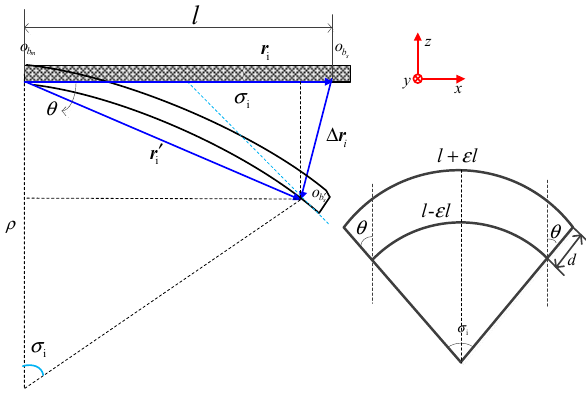
Figure 5. Schematic diagram of the micro arc after the bending deformation of the beam.